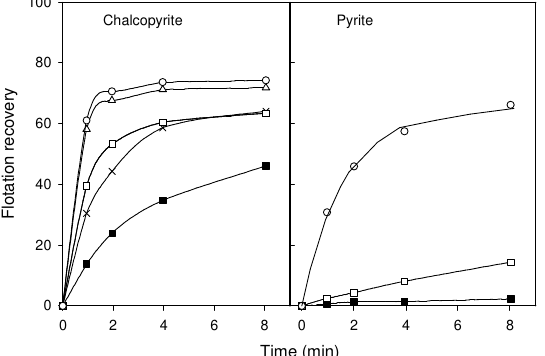
Figure 16. Experimental (symbols) and calculated (lines) flotation of chalcopyrite and pyrite as a function of flotation time and IBECTC ( O -isobutyl-Nethoxycarbonyl thionocarbamate) concentration at ( ■ ) 0, (+) 5 × 10 −6 , (□) 10 −5 , (∆) 5 × 10 −5 and ( ○ ) 10 −4 mol dm −3 (2 g dm −3 of mineral). Water pretreated at pH 7 with 0.01 mol dm −3 of KCl as electrolyte and floated with nitrogen (adapted from Fairthorne et al. [14]).